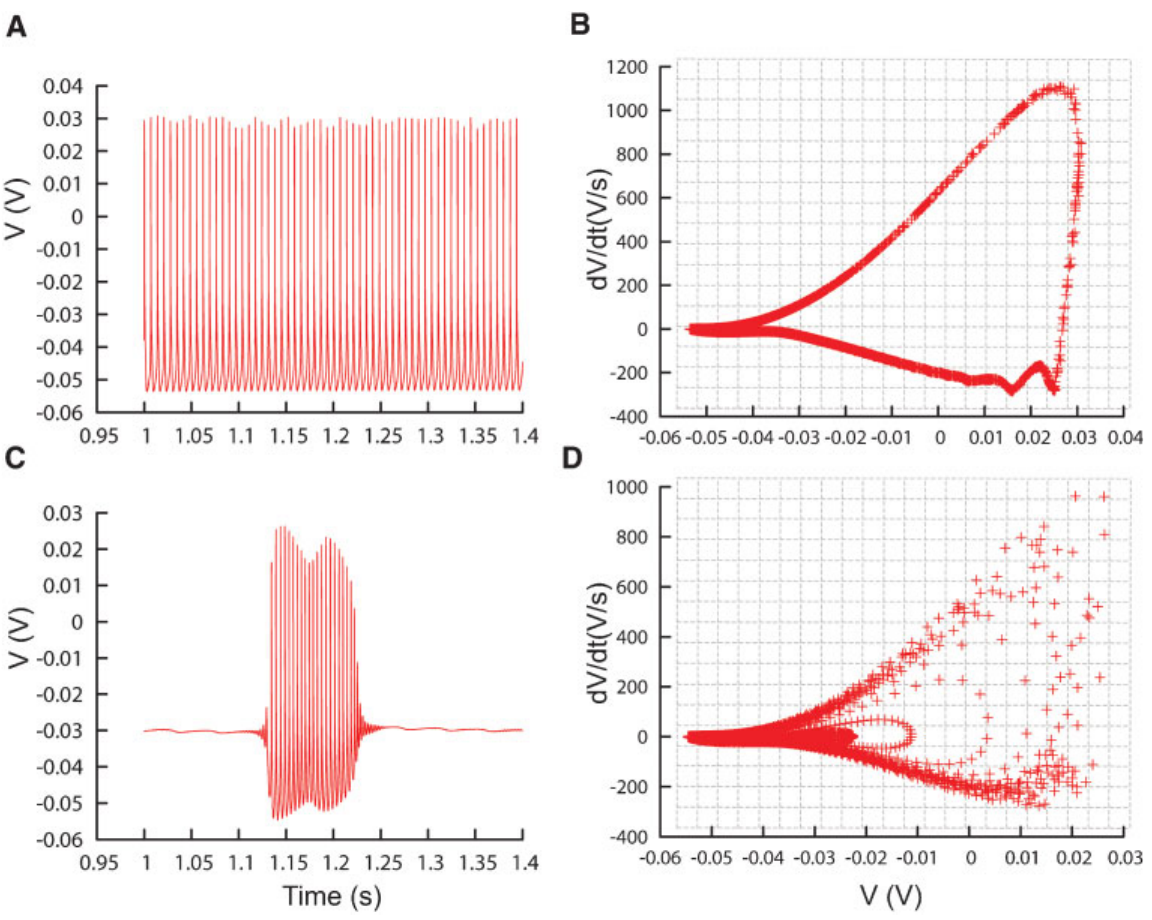
Figure 6. Phase-plane trajectory density plots . ( A ) Traces recorded from the PC model (De Schutter and Bower, 1994) during constant current injection of 0.5nA, causing the model to tonically fire action potentials. ( B ) V–dV/dt plot corresponding to the trace in ( A ), data sampled every 0.02ms. Gray lines show the bins of the 2D histogram used by the phase-plane trajectory density method. In every bin the number of plot points is counted, the counts are then combined in Equation (1). ( C, D ) Similar to A and B, except that the model is injected with a current of 3nA, causing it to burst. The V–dV/dt plot shows different trajectories corresponding to different action potential